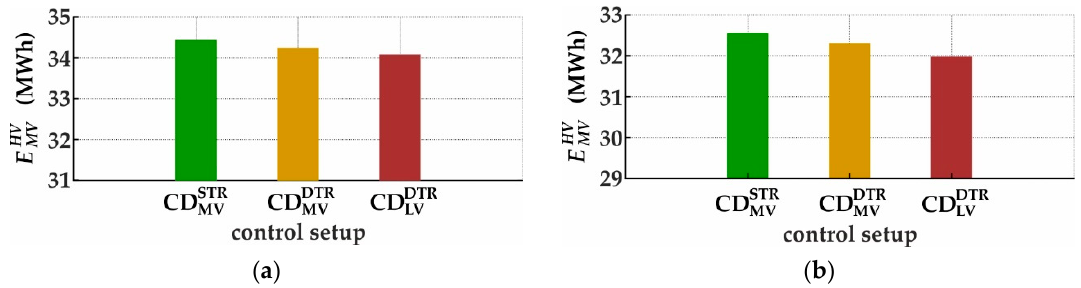
Figure 14. Active energy exchange between MV_and HV_link-grid for different conductor types in MV level: ( a ) cable; ( b ) overhead line.